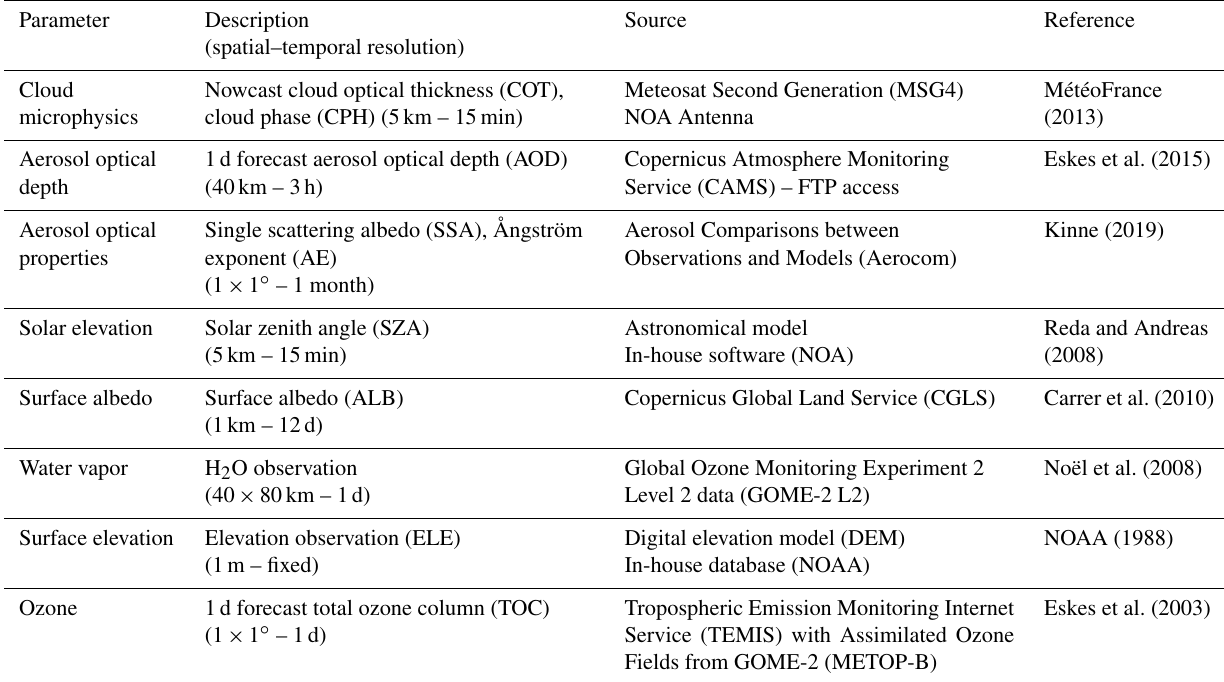
Table 1. UVIOS model input